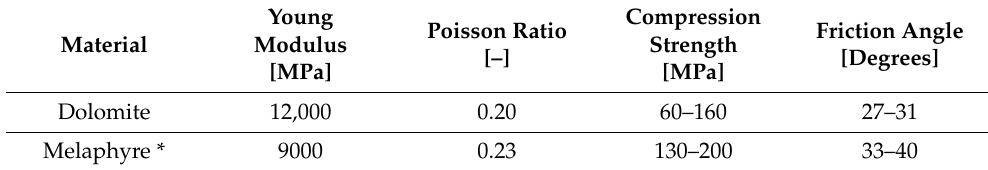
Table 4. Young’s moduli and Poisson’s ratios for aggregates.